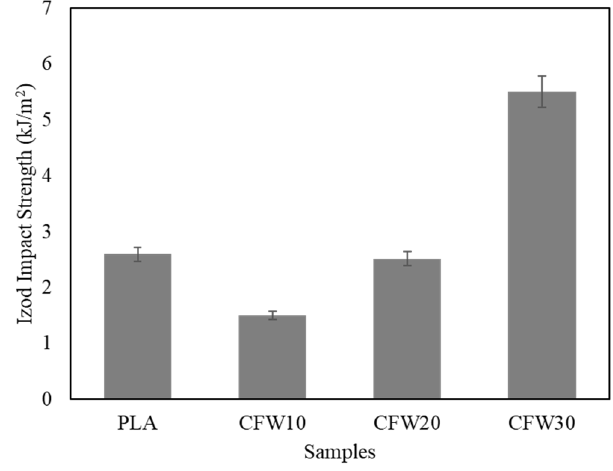
Figure 5. Izod impact strength of PLA/CFW.